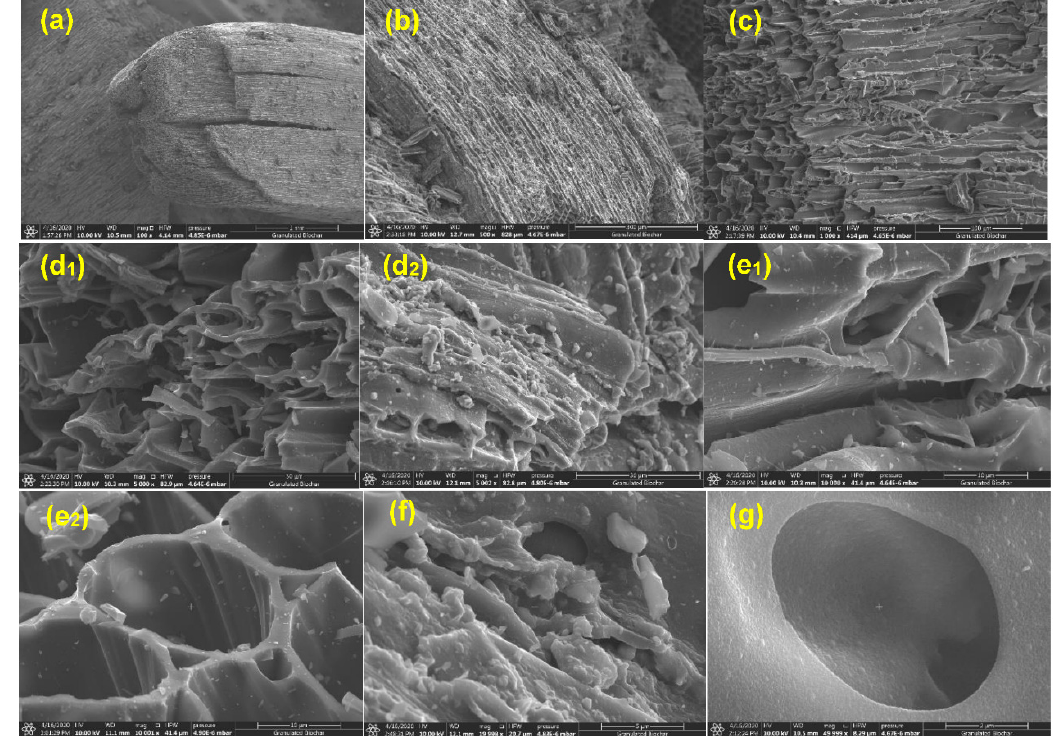
Figure 2. Scanning electron microscopy image of granular biochar at different magnifications and scales: ( a ) 100× mag—1-mm scale; ( b ) 500× mag—300-µm scale; ( c ) 1000× mag—100-µm scale; ( d 1 ) 5000× mag—30-µm scale; ( d 2 ) 5000× mag—30-µm scale; ( e 1 ) 10,000x mag—10-µm scale; ( e 2 ) 10,001× mag—10-µm scale; ( f ) 19,998× mag—5-µm scale; ( g ) 49,999× mag—2-µm scale.